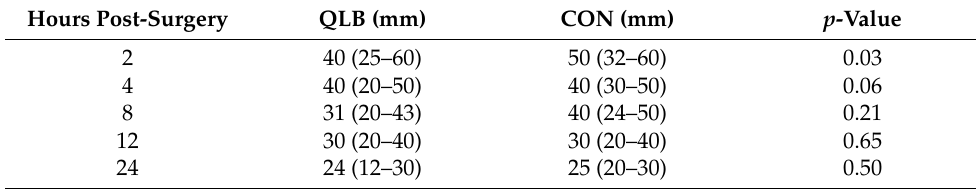
Table 2. Pain intensity after nephrectomy measured with the visual analog